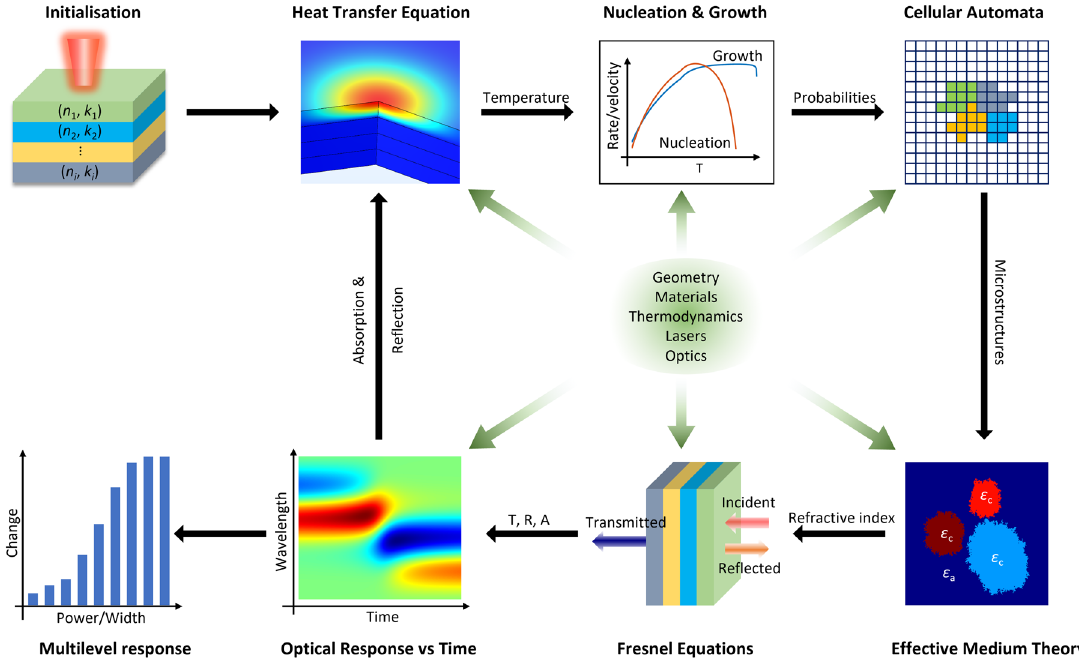
Fig. 1 Schematic of the proposed multi-physics GCA model. The proposed multi-physics GCA model can predict the transient optical response, crystallographic microstructures and multilevel response of an arbitrary PCM device by circularly calculating the temperature distribution through solving the heat transfer equation, the phase of each PCM cell via a modi fi ed GCA model, the effective optical constants by the effective medium theory and the real-time re fl ectivity, transmission and absorption using the Fresnel